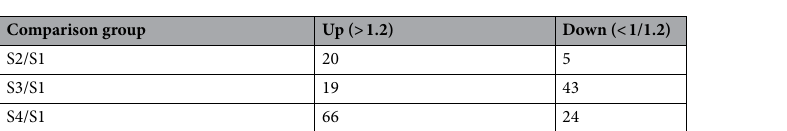
Table 4. Summary of all differentially abundant proteins. S1: control diet; S2: control diet supplemented with 1 μg/kg 1α,25(OH) 2 VD 3 ; S3: control diet supplemented with 2 μg/kg 1α,25(OH) 2 VD 3 ; S4: control diet supplemented with 4 μg/kg 1α,25(OH) 2 VD 3. 1α,25(OH) 2 VD 3 was provided as 1α,25(OH) 2 VD 3 -glycosides from plant